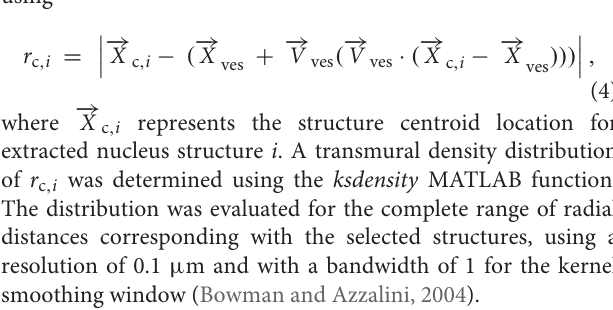
FIGURE 4 | Media borders determined from the transmural elastin voxel density distribution. The two black vertical lines correspond to the radii, with respect to the vessel centerline, where the elastin density first and last exceeds 20% of the maximum elastin density. These locations are used as the radial borders of the vessel